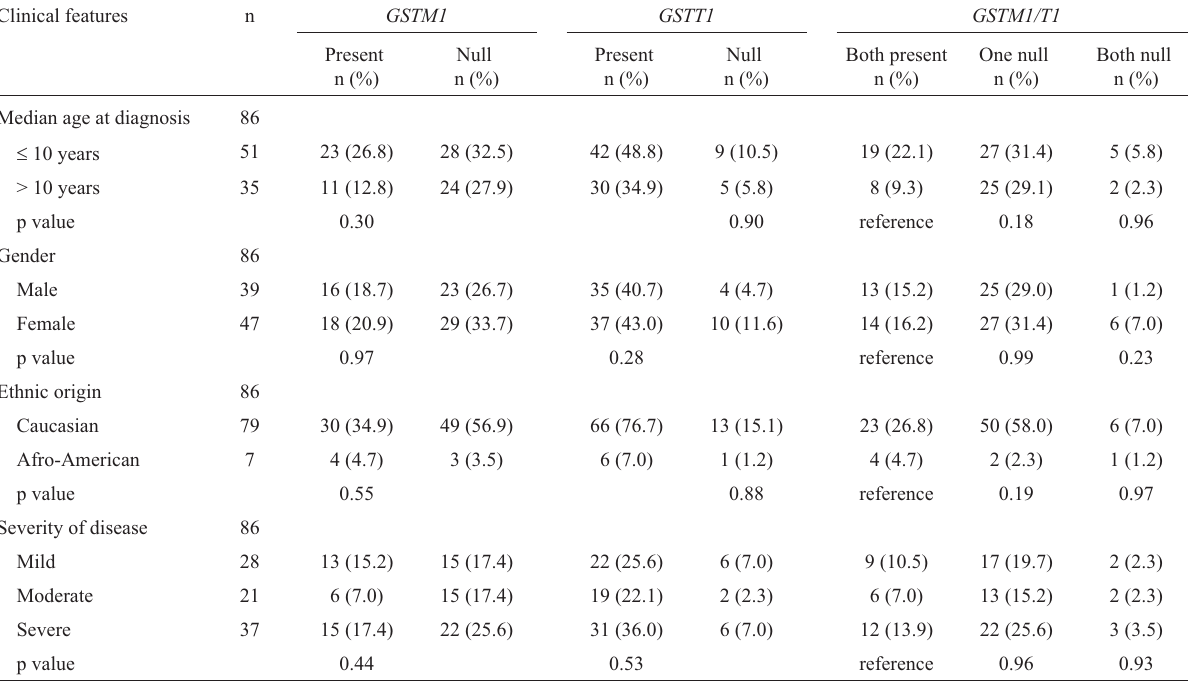
Table 2 - GSTM1 and T1 genotypes in atopic asthma patients stratified by pertinent characteristics. Clinical